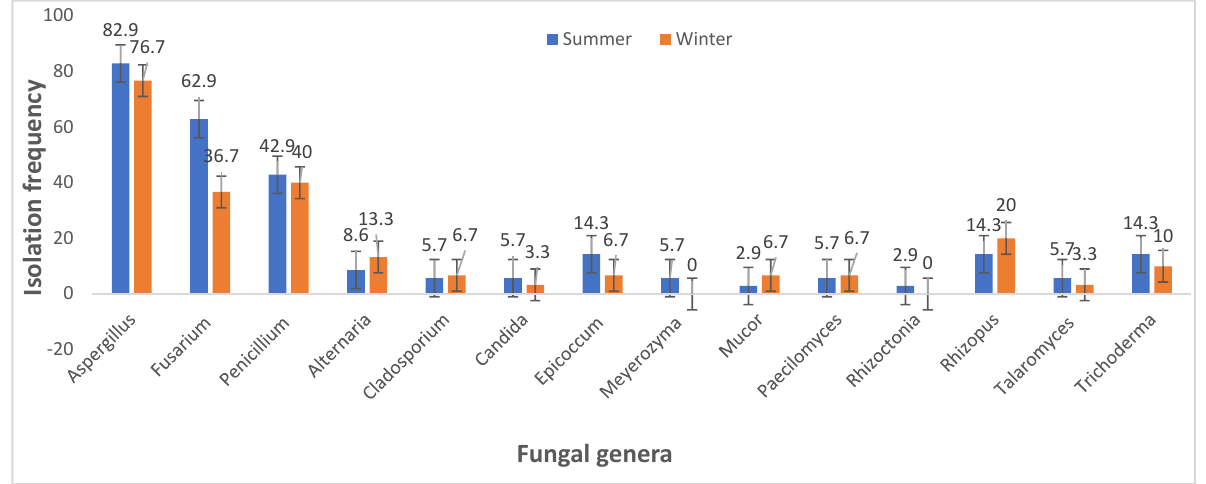
Figure 4. Isolation frequency of fungal genera in dairy cattle feeds and feedstuffs during summer and winter seasons in South Africa. Table 2. Independent sample t -test on variation with isolation frequencies of fungal genera recov- ered from dairy cattle feeds during summer and winter seasons in Free State and Limpopo prov- inces, SA.